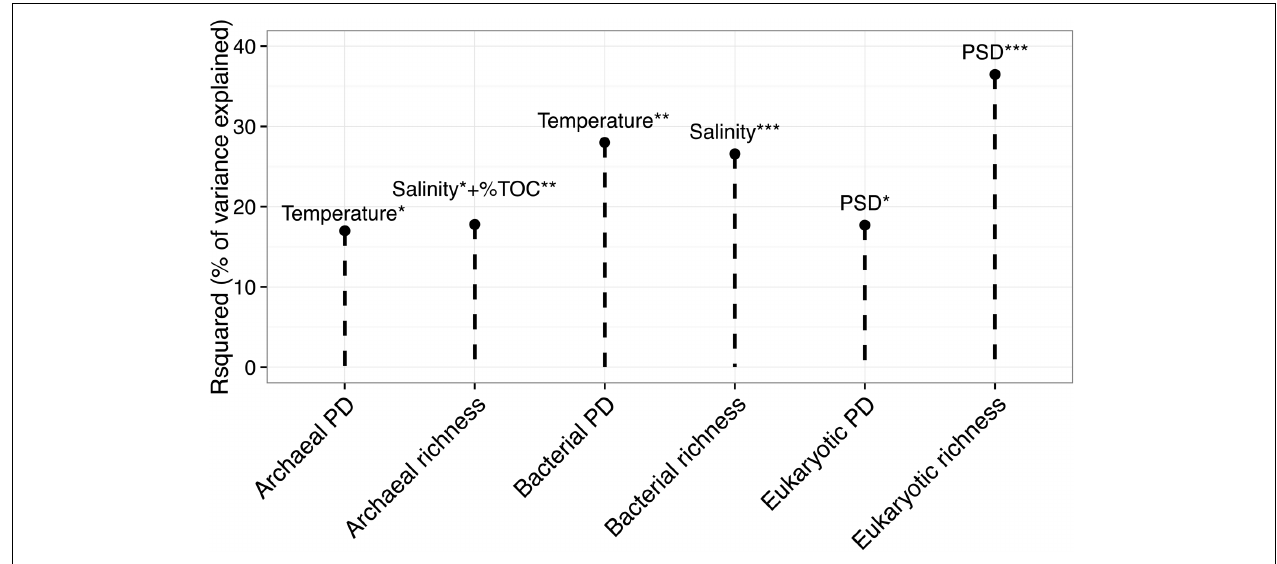
FIGURE 3 | Multiple linear regression model of richness and phylogenetic diversity (PD) of the three kingdoms ( x -axis) against the set of explanatory variables. The y -axis represents the determination coefficient (r-squared). Only significant regressions are shown. Asterisk corresponds to the level of significativity: ∗ p < 0.05, ∗∗ p < 0.01, ∗∗∗ p <